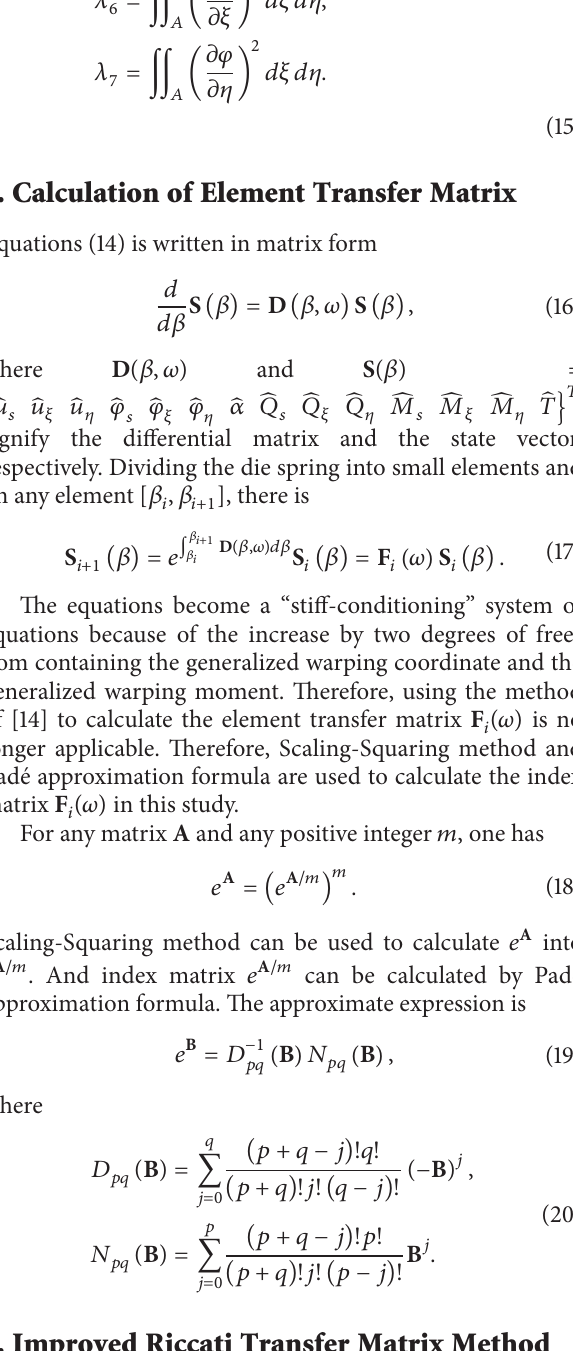
Table 1: Viability and effectiveness of the proposed